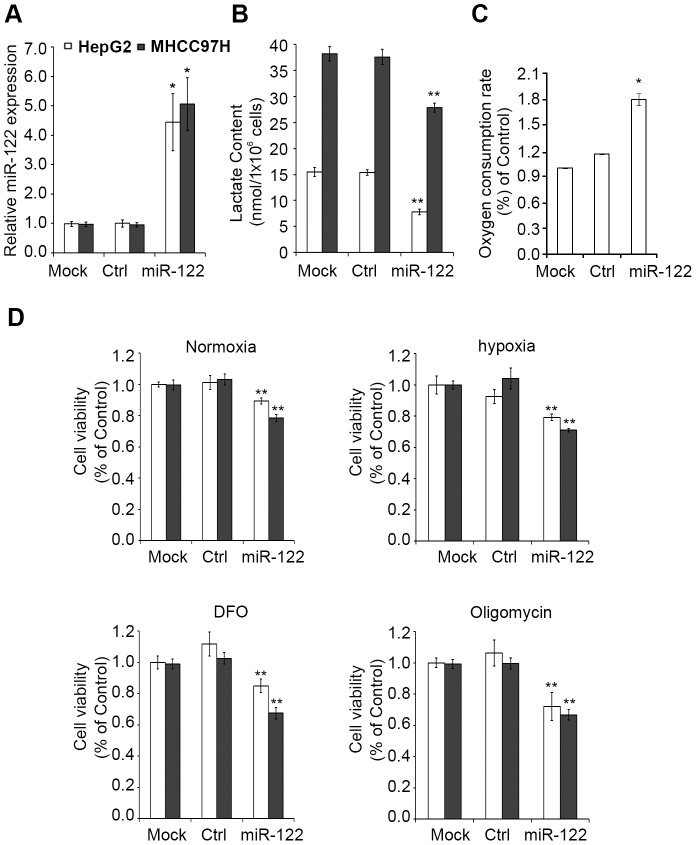
miR-122 expression resulted in reduced aerobic glycolysis of HCC cells.(A) Expression of miR-122 detected by qPCR 48-hour post-transfection in HepG2 or MHCC97H cells. Mock: transfection reagent only; Ctrl: transfection with empty-vector; miR-122: transfection with pc-miR-122. (B) Lactate contents of miR-122 or Ctrl treated cells. (C) Oxygen consumption rate of miR-122 or Ctrl treated cells. (D) Cell viability of miR-122 or Ctrl treated cells under different culturing conditions: normoxia (21% oxygen), 100 uM desferrioxamine (DFO), hypoxia (1% oxygen), or 100 ng/ml of oligomycin. * p<0.05, ** p<0.01, compared to respective Ctrl. Error bars represent S.E.M.